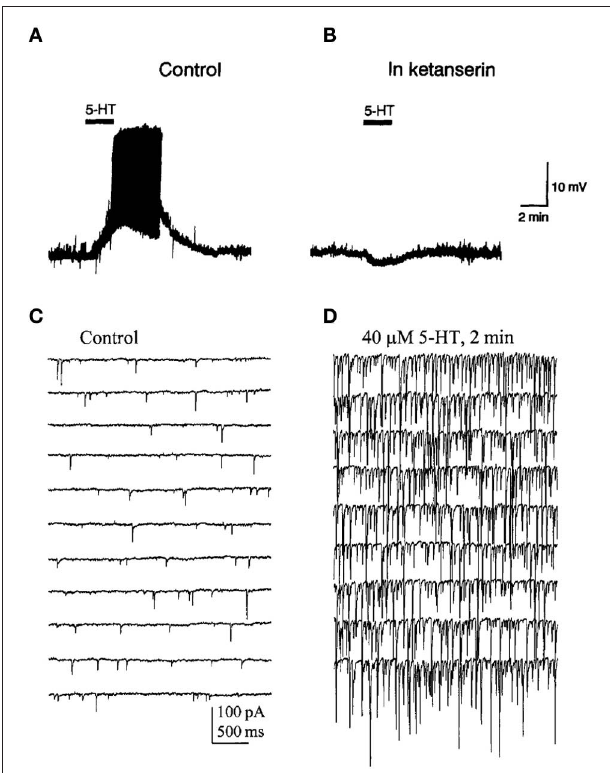
FIGURE 5 | (A) Bath application of 5-HT evoked a depolarization and induced firing in a pyramidal neuron of the PFC. (B) Effect of ketanserin (5-HT 2 A / 2 C receptor antagonist) on the 5-HT-induced membrane depolarization. Notice that in the presence of ketanserin 5-HT elicited a small hyperpolarization. (C,D) Spontaneous IPSCs recorded in a PFC pyramidal neuron in presence of AP-V and CNQX to block glutamatergic inputs. (D) IPSCs evoked by the bath application of 5-HT in the same recording conditions. Note the large increase in the frequency and amplitude of IPSCs induced by 5-HT. Reproduced with permission from Araneda and Andrade (1991) (panels A,B ) and Zhou and Hablitz (1999) (panels C,D